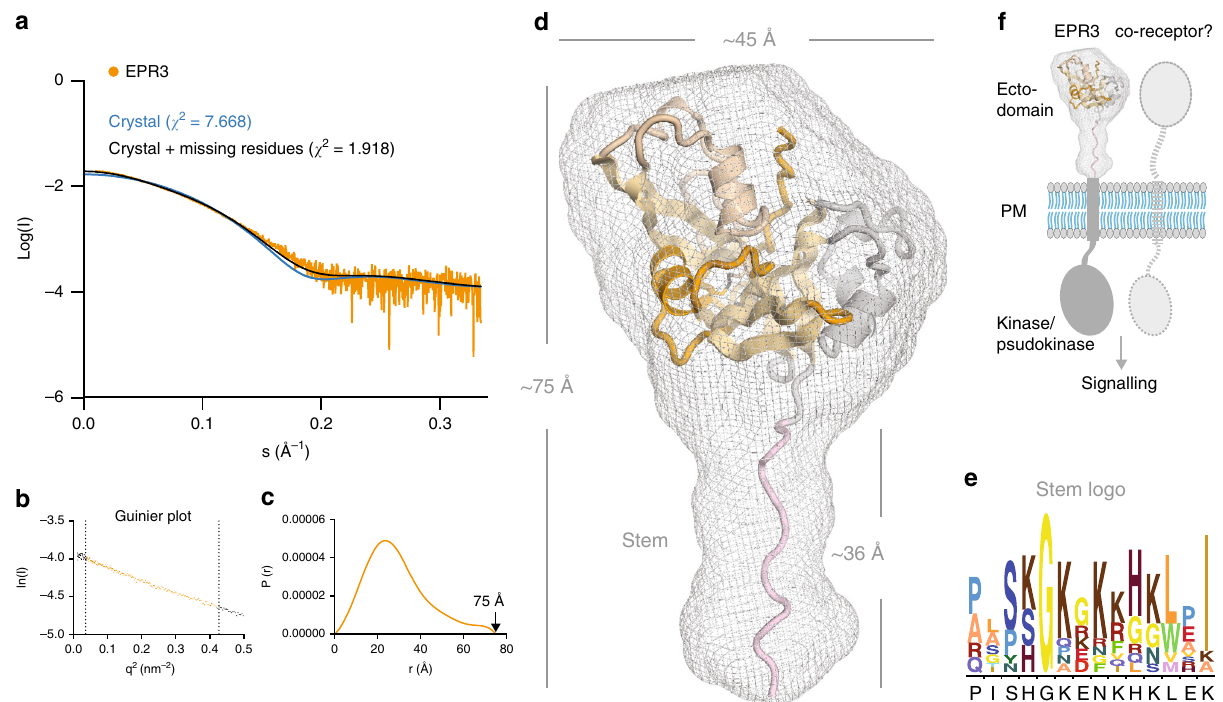
Fig. 3 EPR3 is monomeric and contains a stem-like structure. a SAXS analysis of EPR3 showing scattering curve with fi t to the crystal structure alone ( χ 2 = 7.668) and fi t to the crystal structure rebuilt with the missing residues ( χ 2 = 1.918). b Guinier plots and c P(r) distance-distribution plot with D max = 75 Å. d Rigid-body modelling of the EPR3 crystal structure into the SAXS envelope shows an extended stem-like structure. The overall dimensions are shown in angstrom (Å). e Alignment logo of the stem region of EPR3 homologues with the sequence of Lotus EPR3 shown below 43 . f Model of the EPR3 receptor where the stem structure positions the ectodomain with a distance to the plasma membrane (PM) possible for ef fi cient signalling or interaction to a